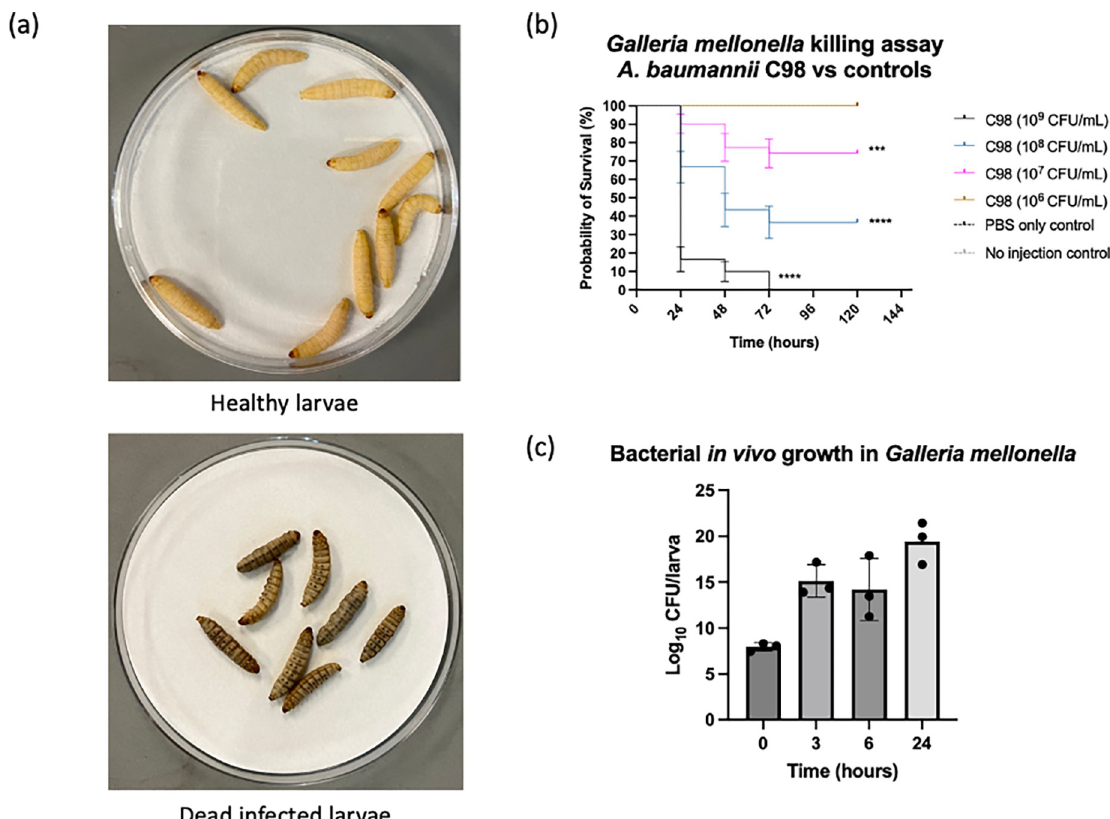
Fig 3. G . mellonella infection assays. (a) Healthy larvae have a white-creamy appearance with no melanisation. Dead infected larvae showed different levels of melanisation and were unresponsive to physical stimuli. (b) Kaplan-Meier survival curves of the killing assay. The results showed that A . baumannii strain C98 killed G . mellonella dose-dependently. (c) Bar chart of bacterial growth in vivo . The results demonstrated that A . baumannii strain C98 increased rapidly in the G . mellonella after 3 hours of